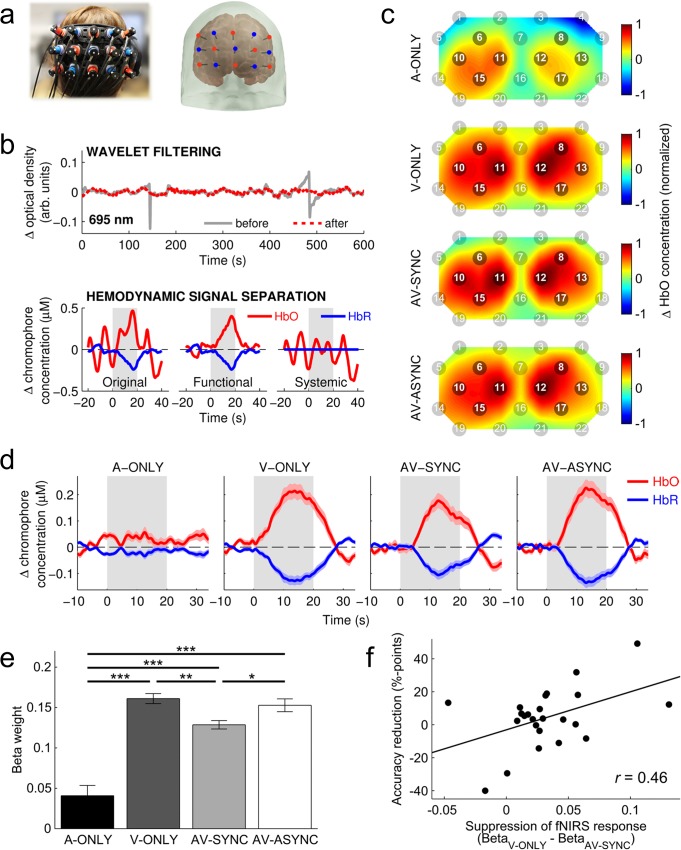
fNIRS Analysis and Results.(a) Photograph of the optode array on one participant and corresponding optode positions registered to an atlas brain. (b) Representative examples of the effect of two key signal processing stages: (upper panel) wavelet filtering successfully removes spikes from the optical signal, while leaving portions of the signal that are not contaminated by motion artifacts unchanged; (lower panel) for a hemodynamic response function showing substantial contamination by physiological noise, the hemodynamic signal separation technique successfully recovers a plausible functional response, plus an estimate of the systemic interference. (c) Group-average patterns of activation (normalized mean change in HbO between 6 and 20 s post onset) across the array for each stimulation condition. Channels within the predefined ROI (Ch# 6, 8, 10–13, 15, and 17) are highlighted. (d) Group-average hemodynamic response functions within the ROI for each stimulation condition. The shaded gray area shows the stimulation period. (e) Mean beta weights from the GLM analysis. Error bars show ±1 standard error, corrected to account for the repeated-measures nature of the design [57]. Asterisks denote a statistically significant difference between the conditions indicated (* p <. 05; ** p <. 01; *** p <. 001; Bonferroni corrected). (f) Assessment of a possible relationship between the suppressive effect of synchronous sounds on the fNIRS response from visual cortex (BetaV-ONLY—BetaAV-SYNC) and a corresponding reduction in the accuracy of visual target detection (AccuracyV-ONLY − AccuracyAV-SYNC). While Pearson’s correlation suggested a significant linear relationship (r = .46, p = .023, two-tailed), this result could not be confirmed by a robust regression analysis (p = .136).